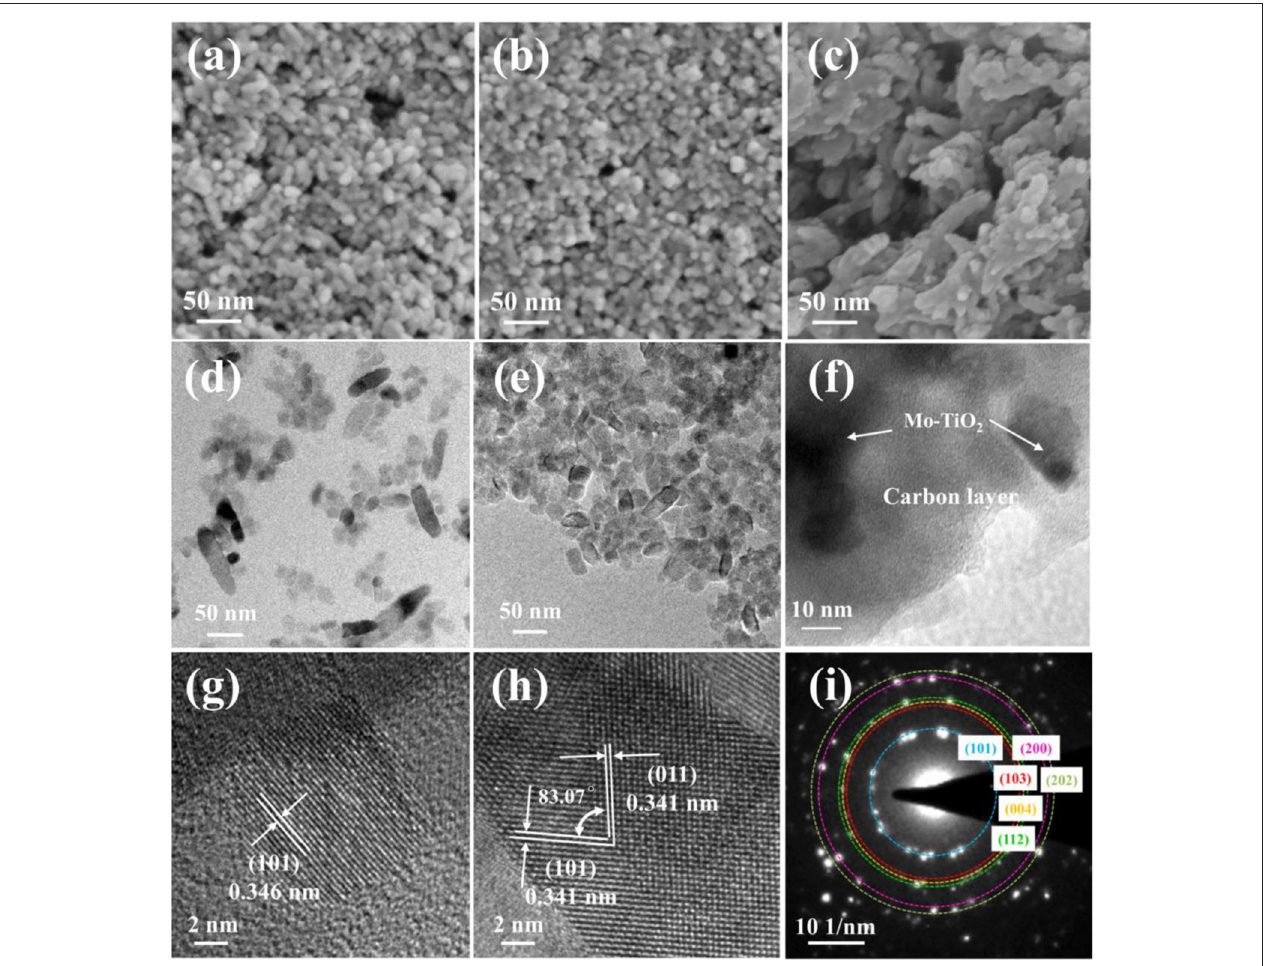
FIGURE 2 | SEM images of TiO 2 (a) , Mo-TiO 2 (b) , and Mo-TiO 2 @NC (c) . TEM images of TiO 2 (d) , Mo-TiO 2 (e) , and Mo-TiO 2 @NC (f) . HRTEM images of TiO 2 (g) and Mo-TiO 2 (h) , (i) SAED pattern of Mo-TiO 2